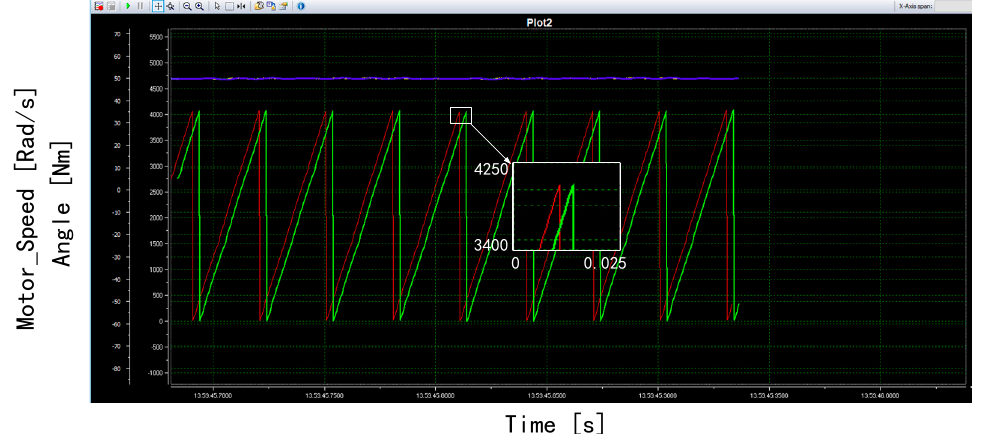
Figure 22. Comparison of motor speed and rotor position with the traditional SMO observer at 50 rad/s.